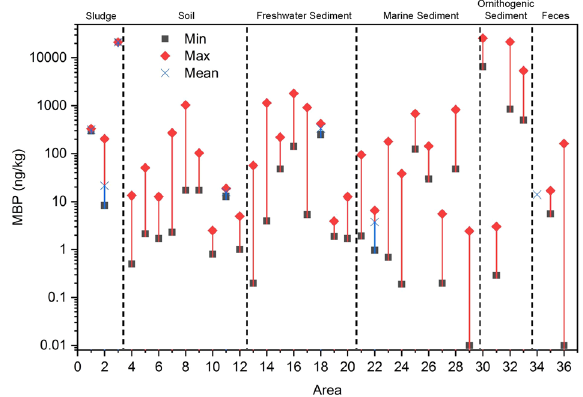
Fig. 2 Survey of the presence of matrix-bound phosphine in the environment. (Sludge 5,40,41 : 1. WWTP in Beijing, 2. WWTPs